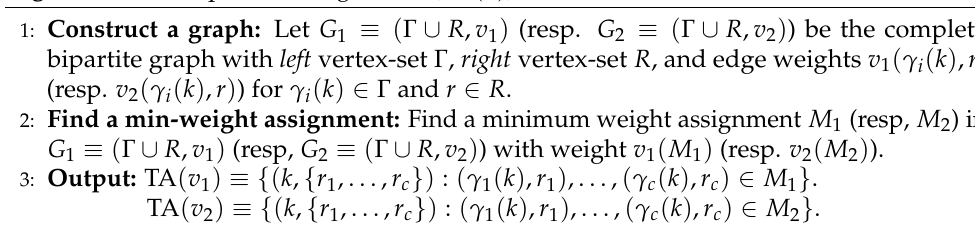
Algorithm 1 Transportation algorithm (TA ( v )